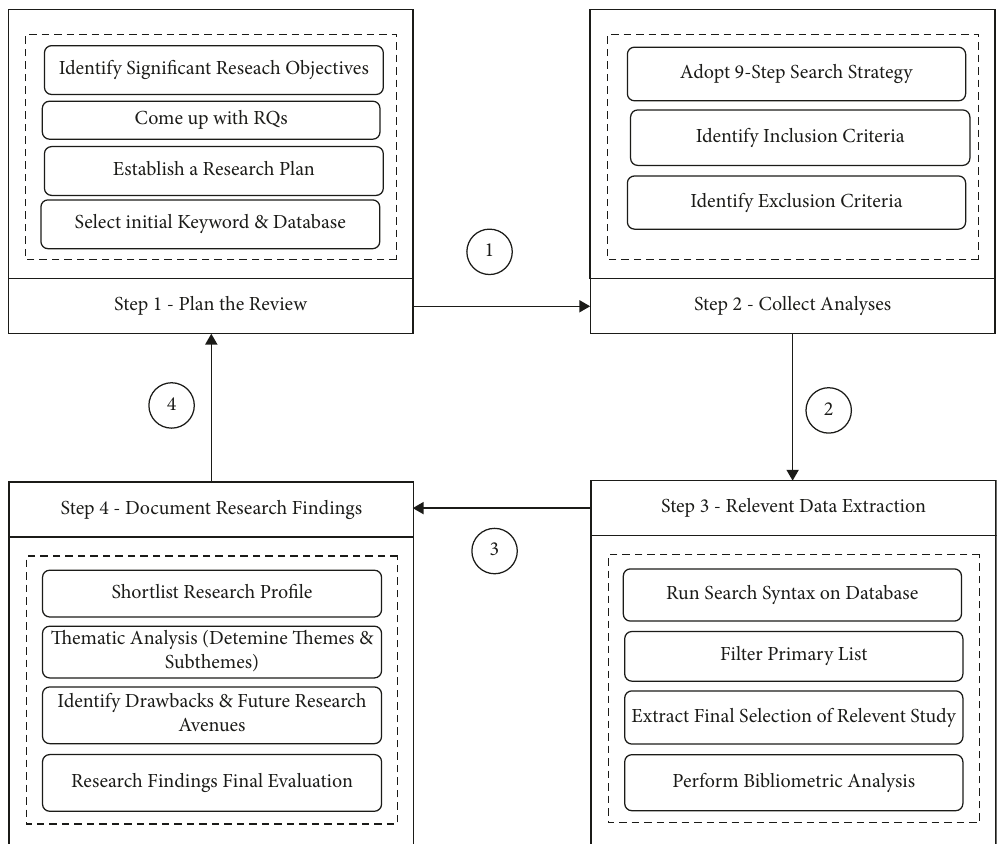
Figure 1: SLR methodology and